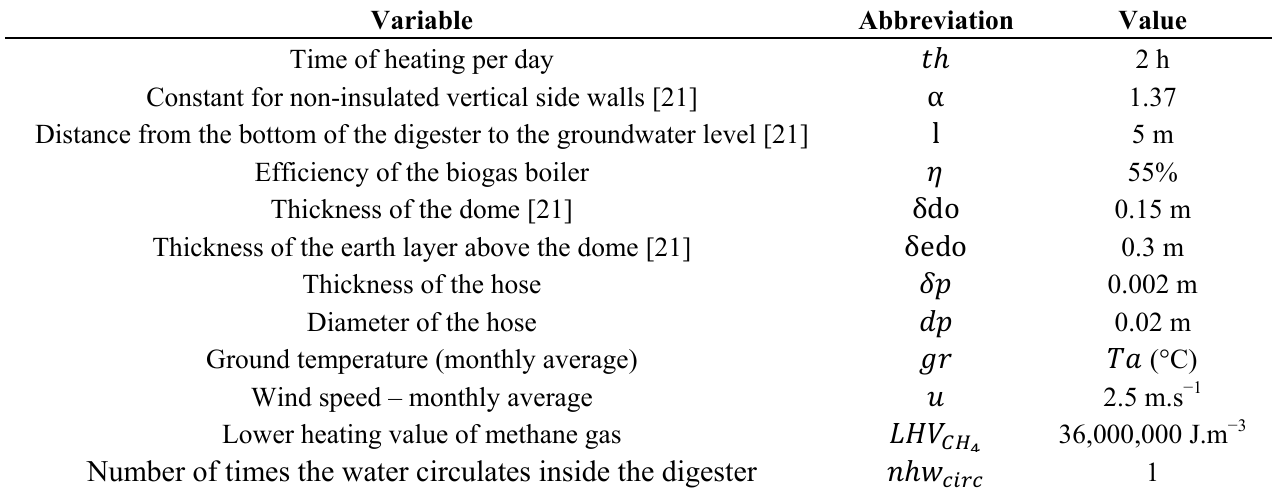
Table 4. Parameters used in the